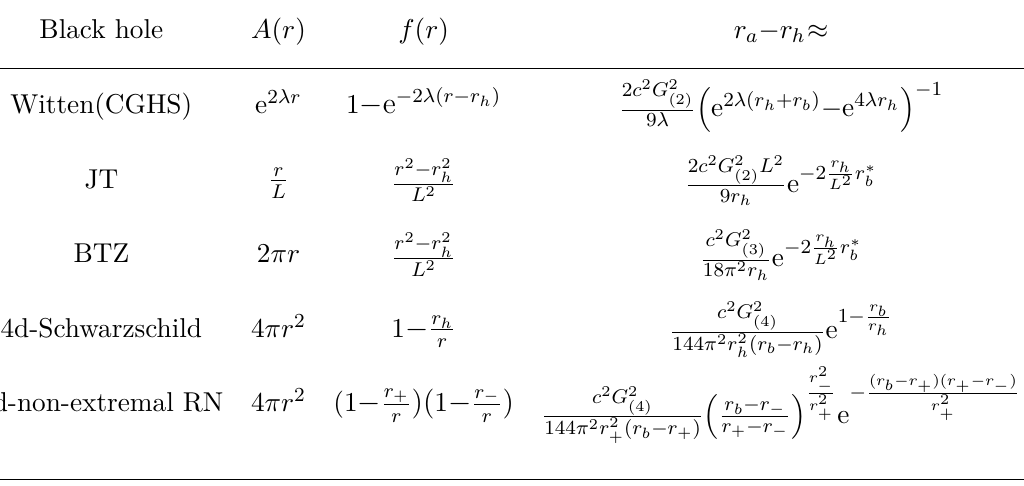
Table 1. Approximations of location of quantum extremal surface for several black